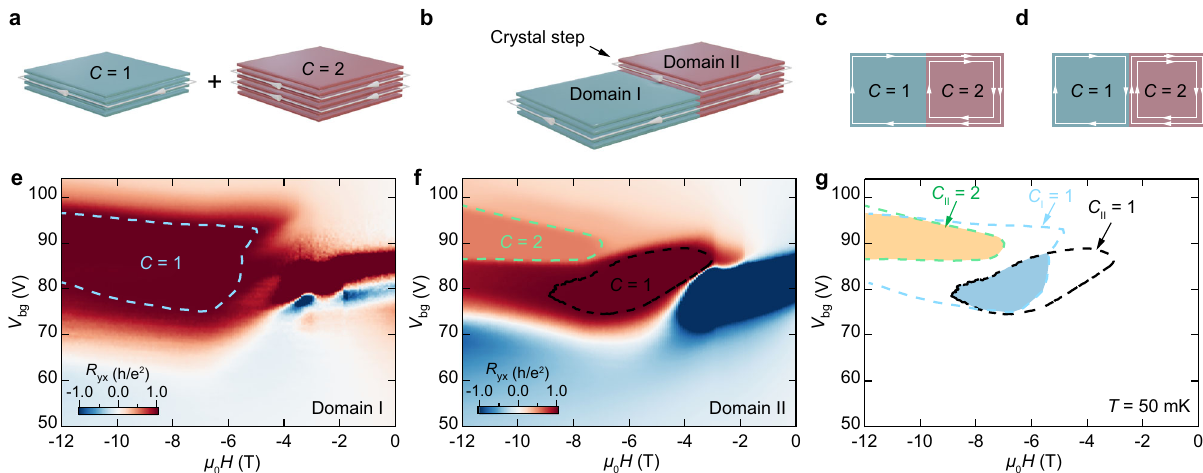
Fig. 1 | Creating a Chern junction in MnBi 2 Te 4 . a – c Concept of the junction. a A thinner MBT fl ake (Domain I) hosts a chiral edge state with Chern number C =1 while a thicker fl ake (Domain II) hosts two chiral edge conduction channels with C =2. b AChernjunction isformedat astep in thicknessinasingle fl ake. c – d Show two possible scenarios for the chiral edge states at the junction. e – g Character- ization of Device 1, which contains a 4-layer (Domain I) to 6-layer (Domain II) junction. All data are taken at T =50mK. e Hall resistance R yx as a function of back